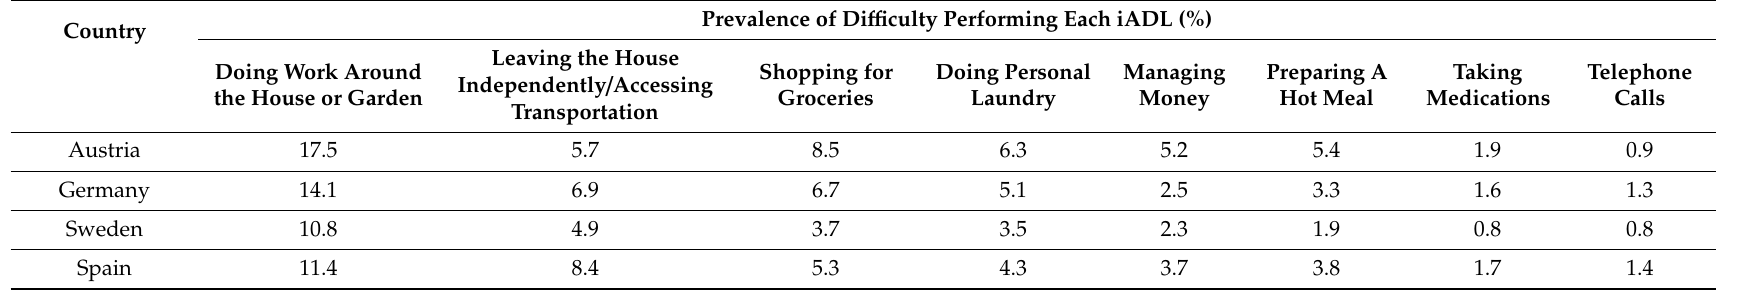
Table 2. Prevalence of di ffi culty performing each iADL (%) by country. iADL (Instrumental activity of daily